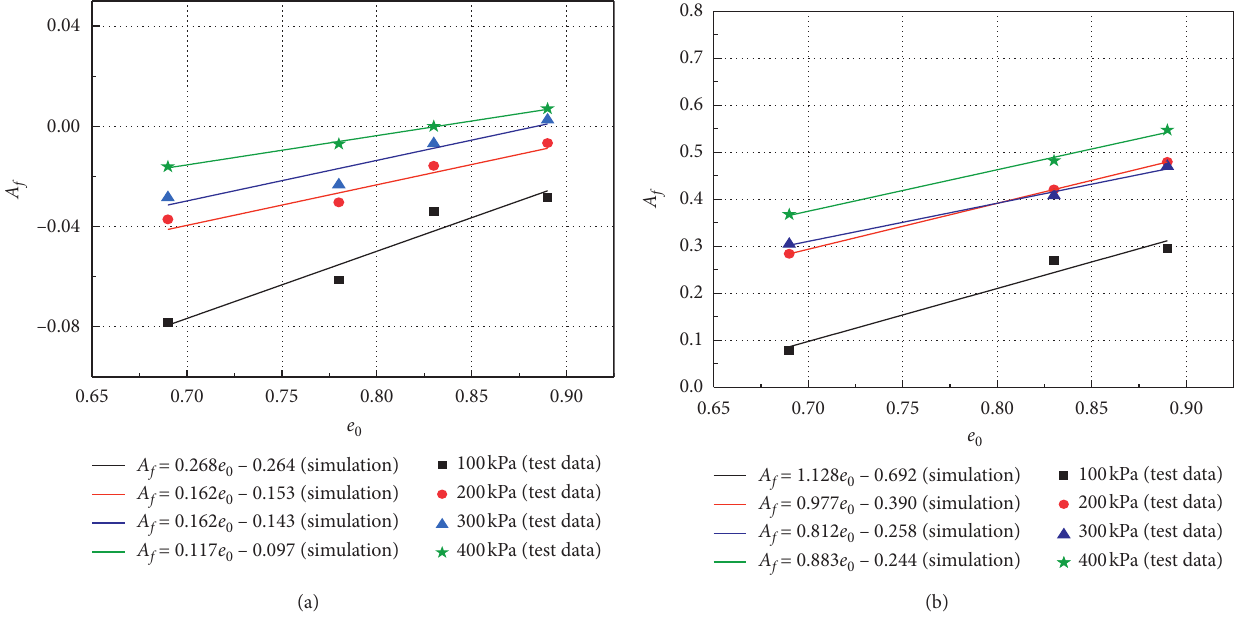
Figure 10: Relationship between a f and e 0 : (a) coral mud and (b) Taizhou soil.